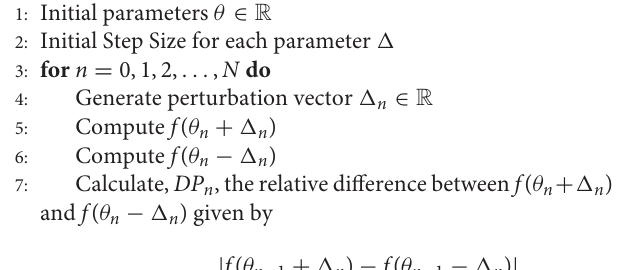
TABLE 3 | The selected elasticsearch parameters. Parameter translog.sync.interval